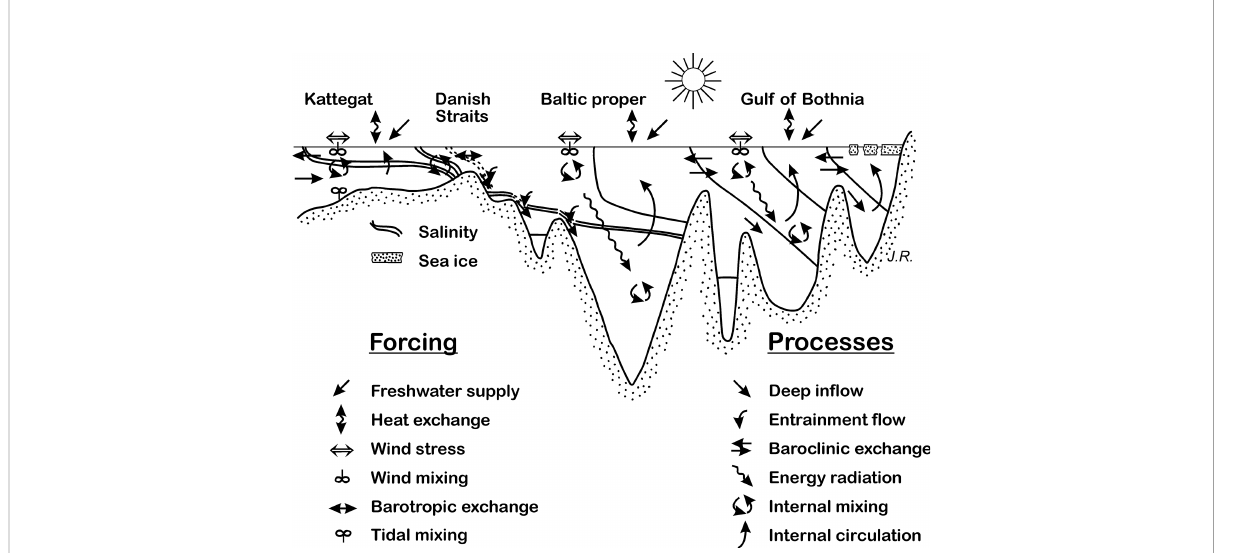
FIGURE 2 Schematic of processes and forcing mechanisms in the Baltic Sea, where the tilted lines illustrate the salinity strati fi cation (redrawn from Winsor et al., 2001; Winsor et al.,